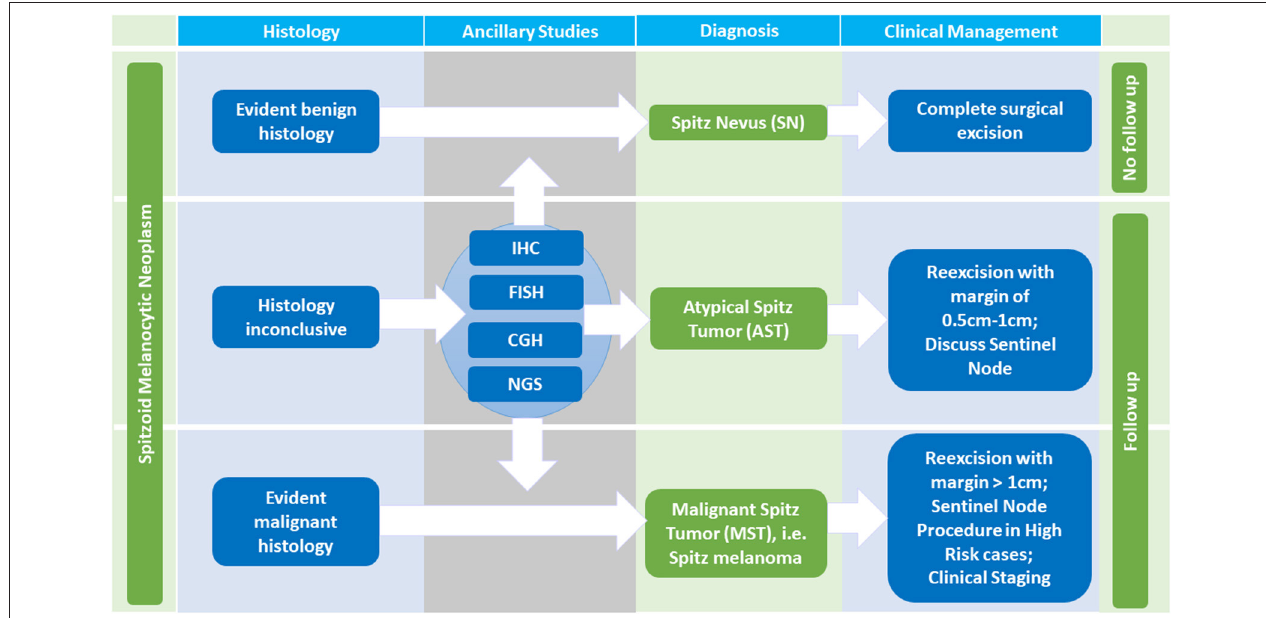
FIGURE 3 | Diagnosis and Management of Spitzoid Melanocytic Neoplasms. Histopathologic evaluation is the initial step in diagnosing a Spitzoid neoplasm. In case of evident benign histologic characteristics, the diagnosis of a Spitz nevus (SN) can be made. If the lesion has been completely excised a clinical follow up is not necessary. In cases of evident malignant histopathology, the diagnosis of Spitz melanoma, i.e., malignant Spitz tumor (MST) is made and clinical management according to conventional malignant melanoma protocols should be followed. The diagnosis of MST necessitates a re-excision with a margin of at least 1cm, in